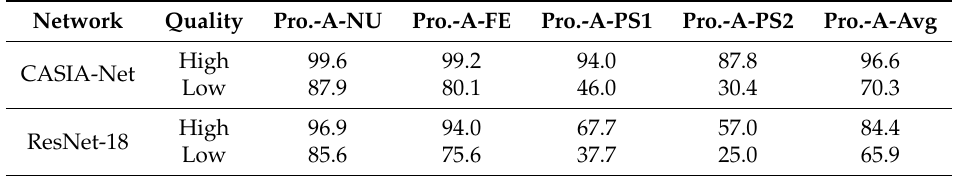
Table 6. Rank-1 identification rates (%) of CASIA-Net and ResNet-18 in face recognition on high-quality and low-quality data sets under variations. Pro. represents